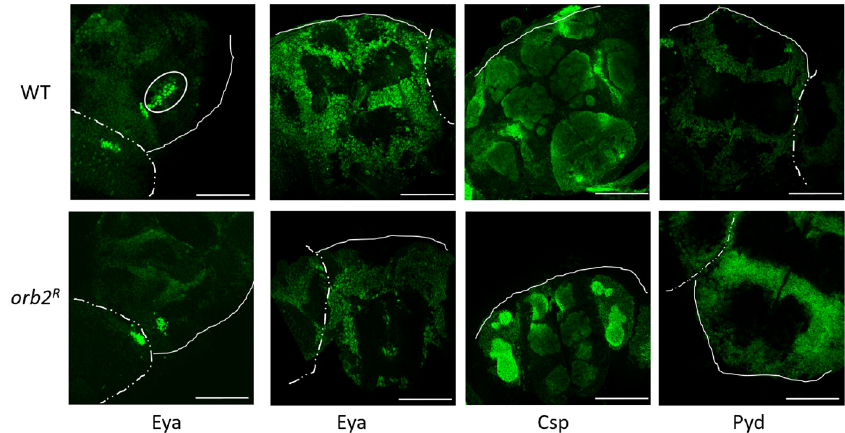
Figure 7. Whole-mount staining of the Drosophila brain in WT and orb2 R flies. Staining was performed with antibodies against the Eya, Csp, and Pyd proteins. A dashed line shows the board between the optic lobe and the central brain, and a solid line shows the board of the central brain. White ovals show a group of cells whose nuclei were stained with the antibody against the Eya protein in WT. For each antibody staining, the same exposure was used for samples of WT and Orb2 R